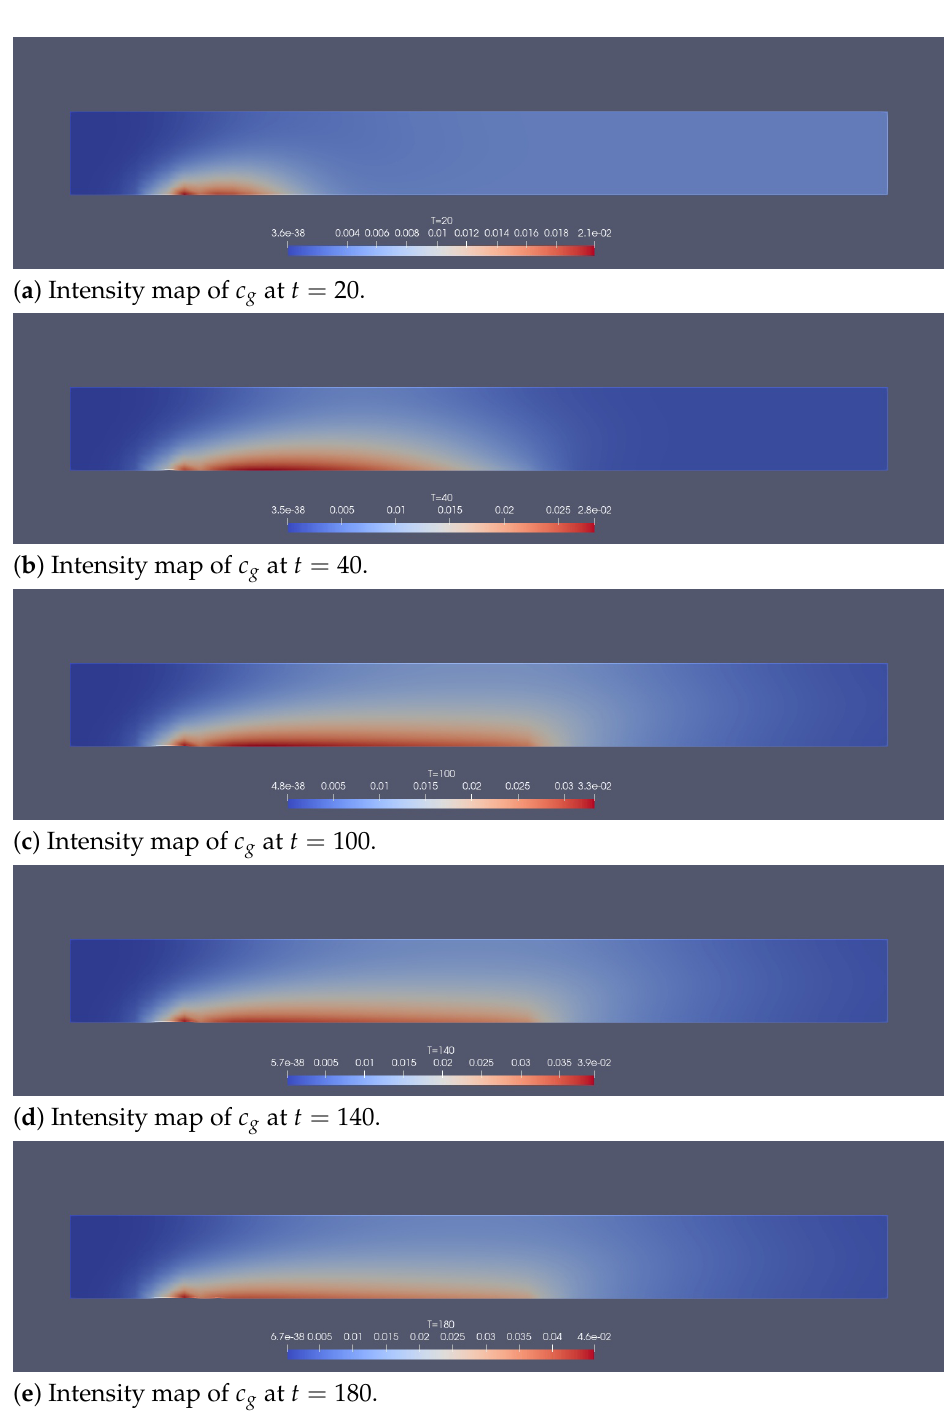
Figure 2. For Section 5.2: intensity maps of the concentration of dissolved gas. Notice that the gas seems to prefer to go up rather than to the